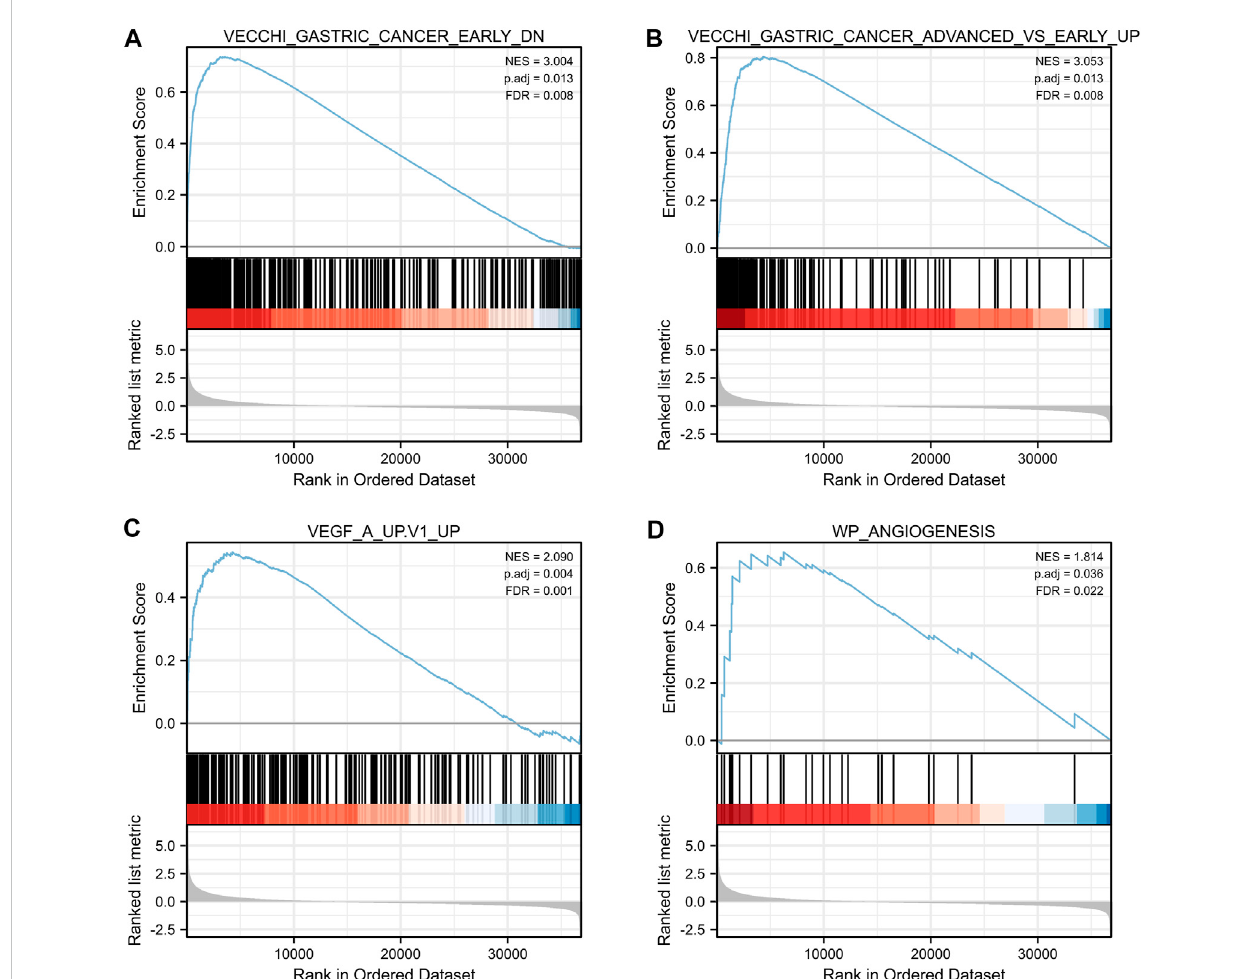
FIGURE 7 Single gene enrichment analysis of CNN1. (A) VECCHI_GASTRIC_CANCER_EARLY_DN. (B) VECCHI_GASTRIC_CANCER_ADVANCED_VS_EARLY_ UP. (C) VEGF_A_UP.V1_UP. (D)